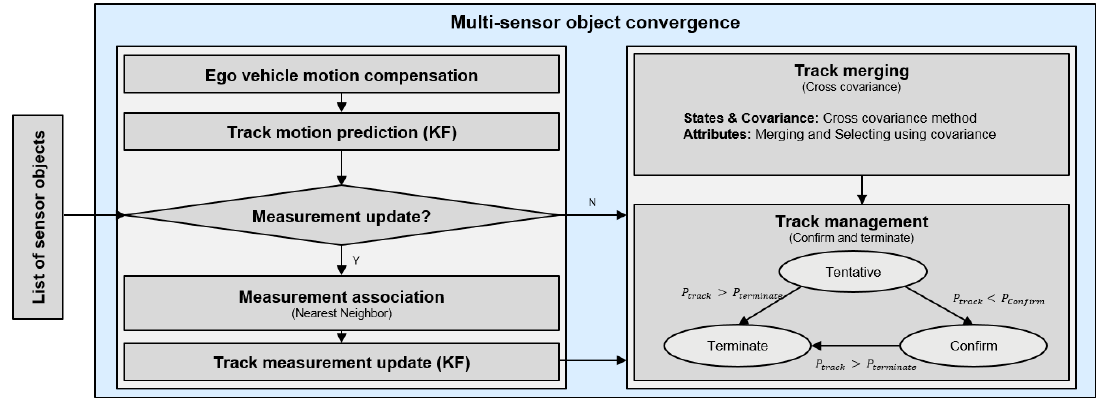
Figure 4. The system architecture of multi-sensor object